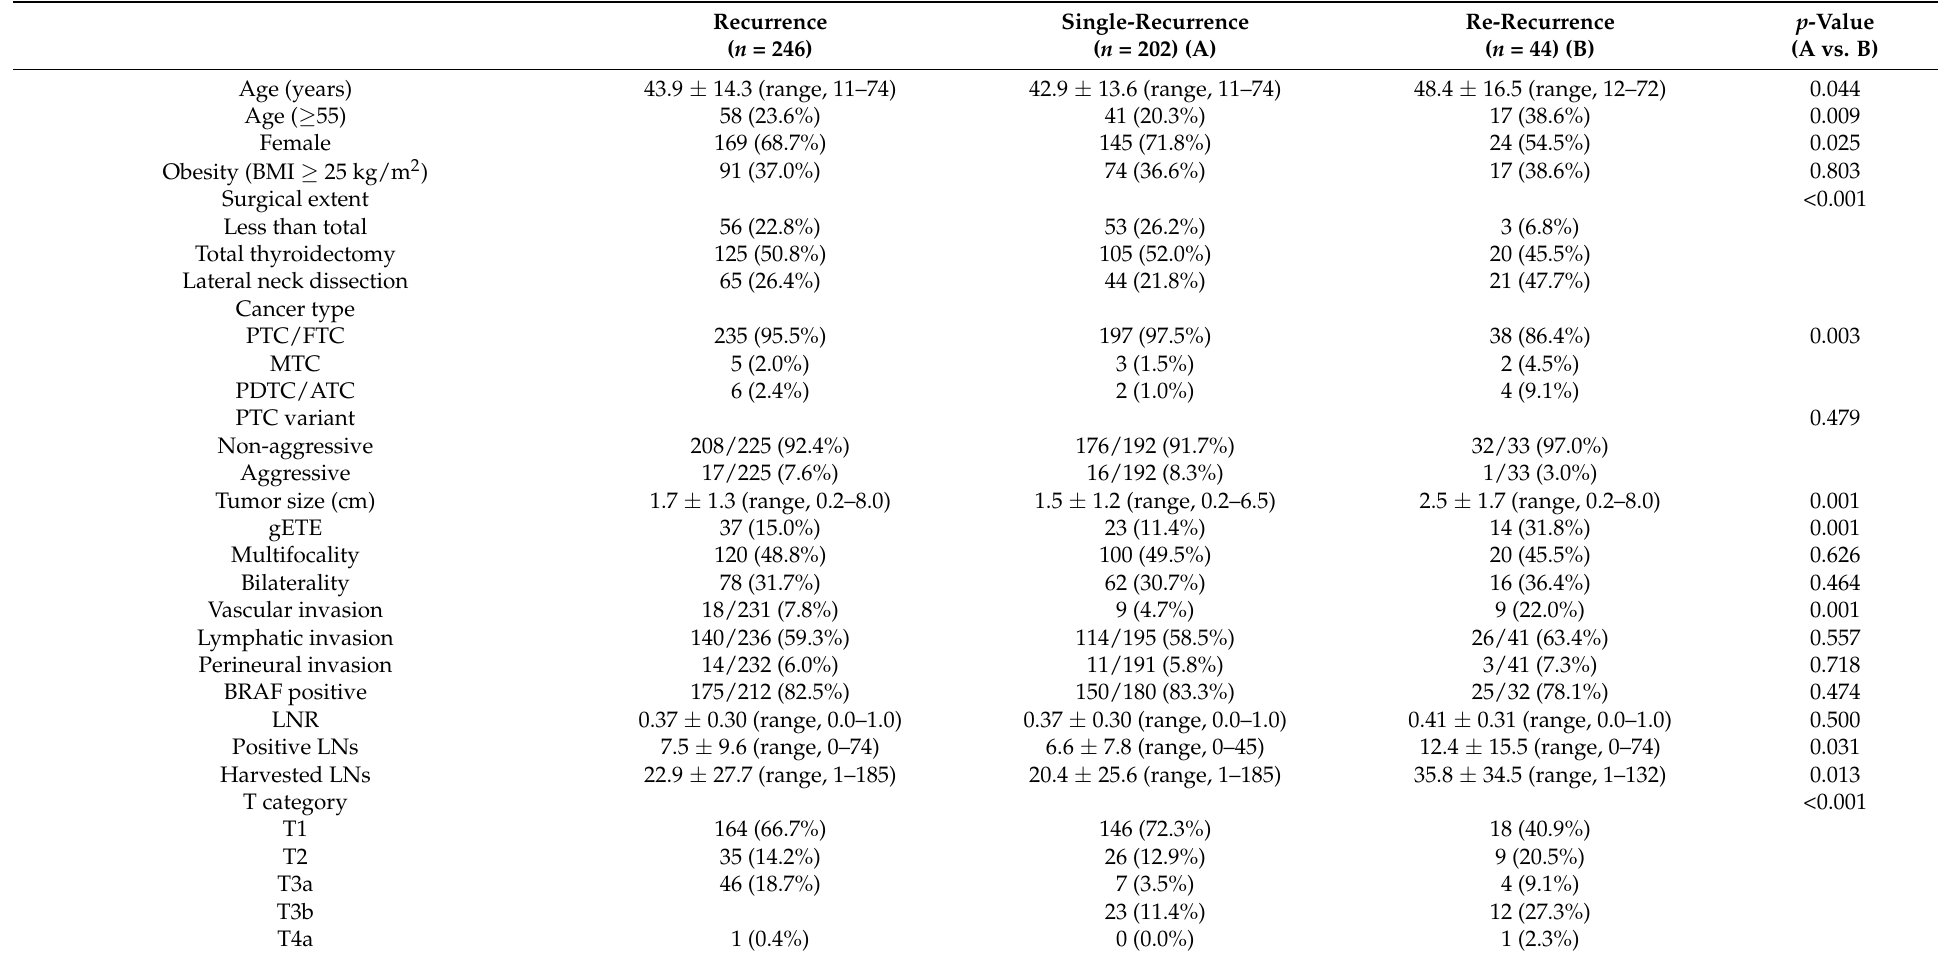
Table 1. Comparison of clinicopathological characteristics according to